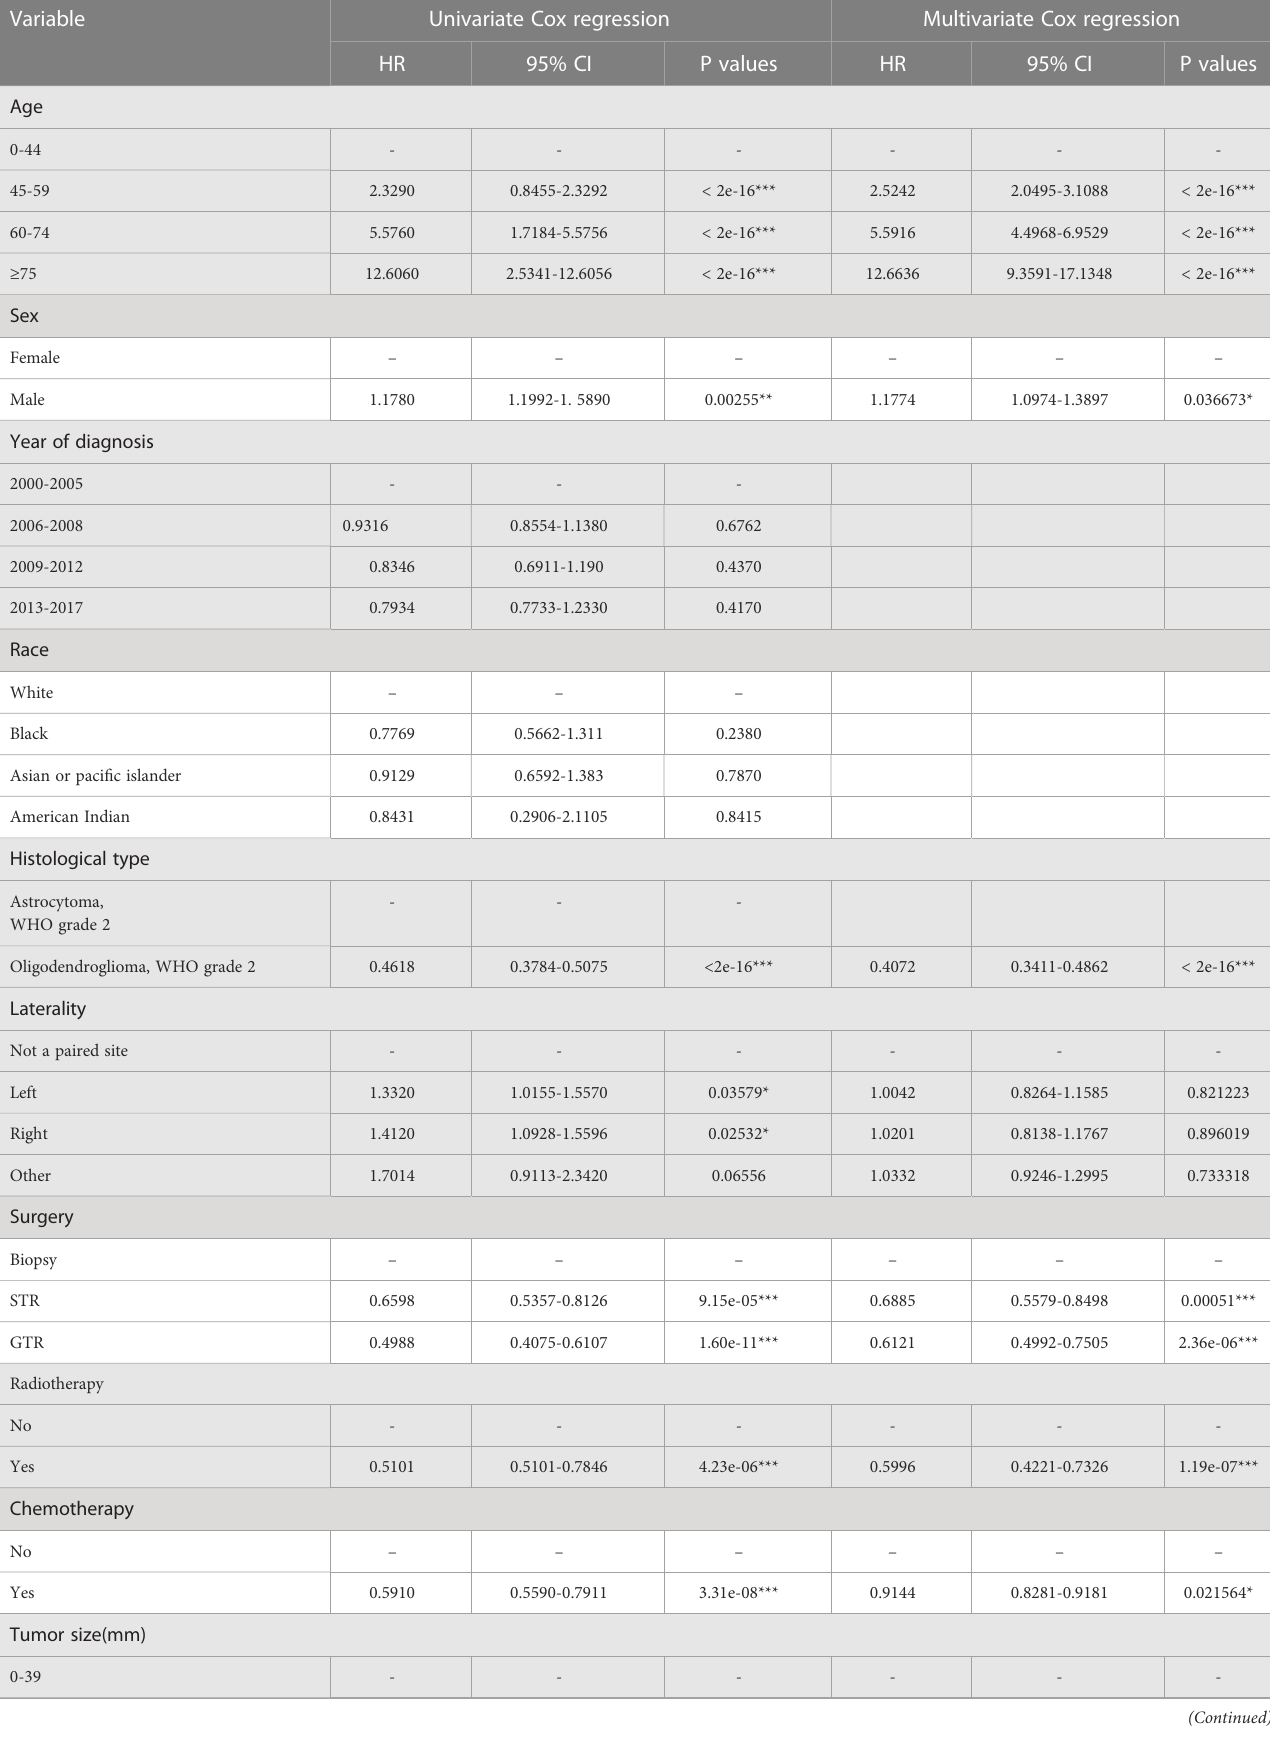
TABLE 2 Univariate and multivariate Cox regression analyses of the training